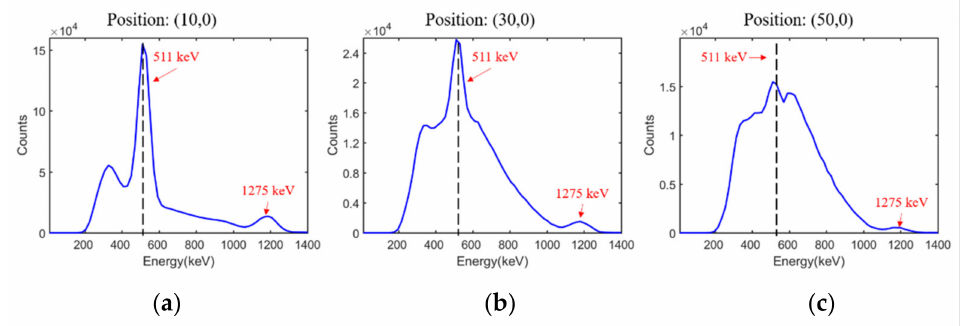
Figure 11. ( a – c ) Energy spectra at positions (10, 0), (30, 0), and (50, 0), respectively.